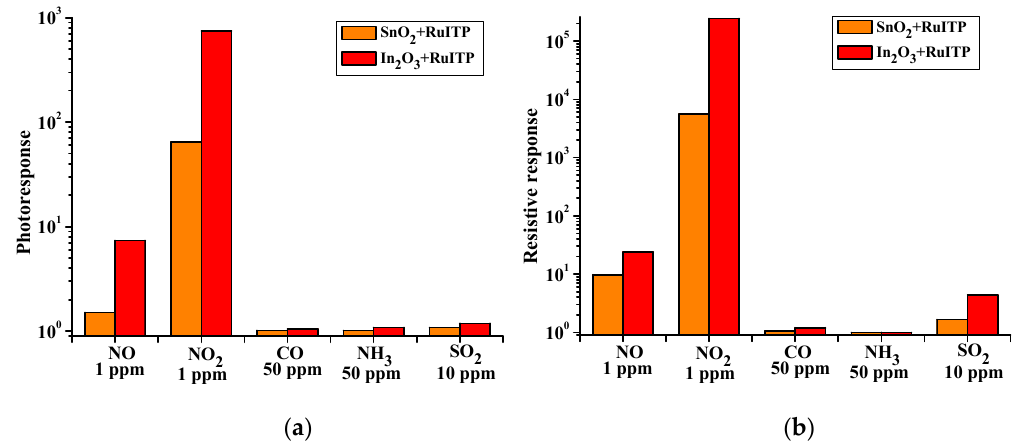
Figure 14. Comparison of the effective photoresponse ( a ) and resistive response ( b ) of hybrid materials when detecting different gases at room temperature under periodic blue light illumination.